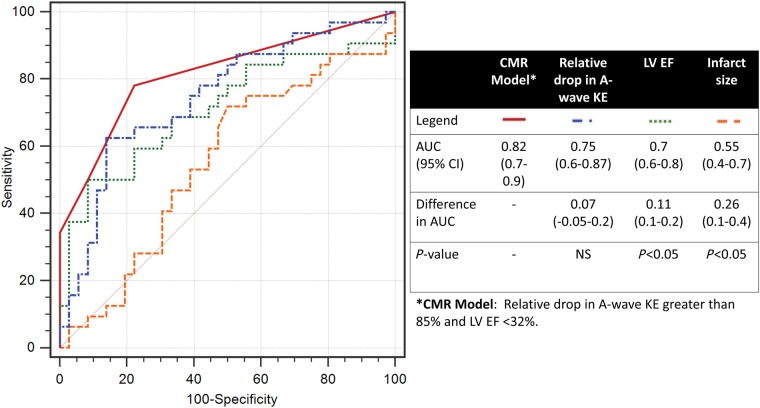
Receiver operating curve analysis for the presence of LVT.